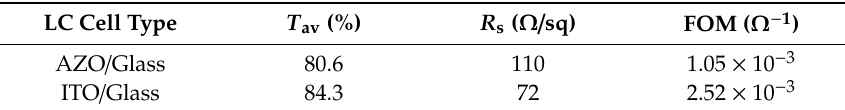
Table 1. Haacke figures of merit